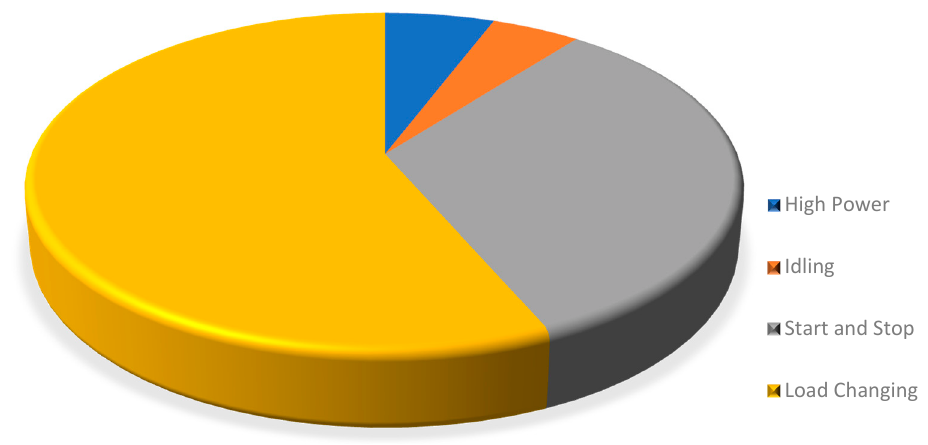
Figure 6. Aging processes of FC (PEMFC) [55].